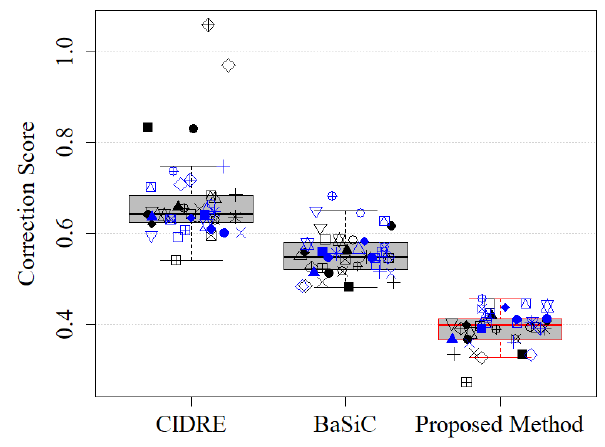
Figure 6. Correction scores of regularized energy minimization (CIDRE), BaSiC and the proposed method. Each symbol represents one of 40 image collections.